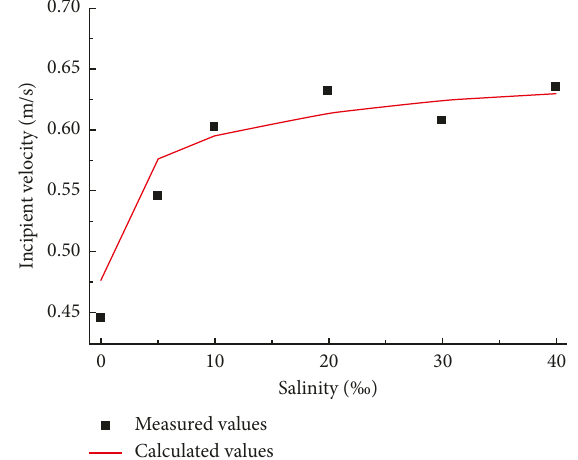
Figure 11: Comparison of calculated and measured critical in- cipient velocity of muddy clay.